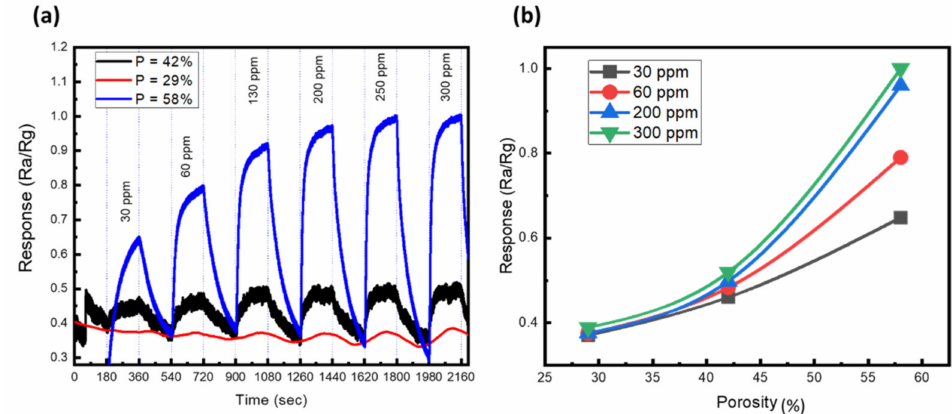
Figure 13. Effect of porosity on H 2 detection at room temperature: ( a ) versus time and ( b ) versus the porosity. Reproduced from [138], with permission from Copyright American Chemical Society,